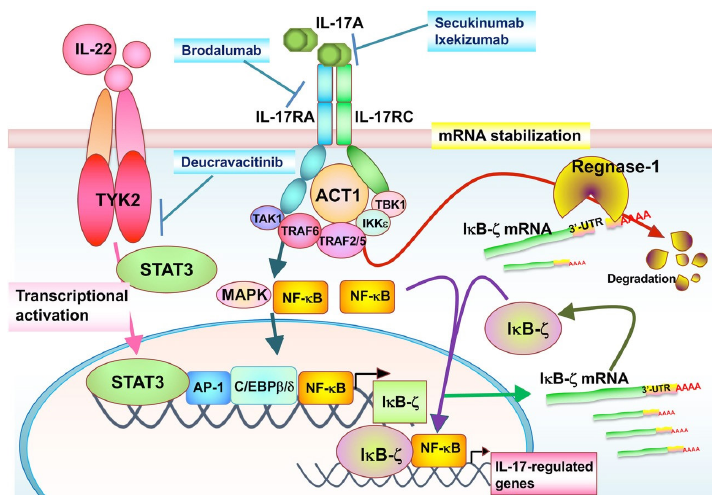
Figure 3. The TYK2/IL-17 axis-mediated signaling in IκB-ζ expression. The STAT3-activating cytokines, such as IL-22, promote TYK2/STAT3 signals in keratinocytes. TYK2/STAT3 signals directly enhance IκB-ζ promoter activity. IL-17A binds to IL-17RA and IL-17RC subunits, whose intracellular domains interact with the adaptor ACT1. ACT1 associates with TRAF family proteins, TBK1 and IKKε. These IL-17 signals posttranscriptionally stabilize IκB-ζ mRNA through inhibition of an endonuclease Regnase-1 independently of TYK2. The TYK2/IL-17 axis is regulated independently of each other, and both of them are required for IL-17-induced IκB-ζ upregulation and further IL-17-regulated gene expression. TAK1: transforming growth factor β-activated kinase 1; MAPK: mitogen-activated protein kinase; AP-1: activating